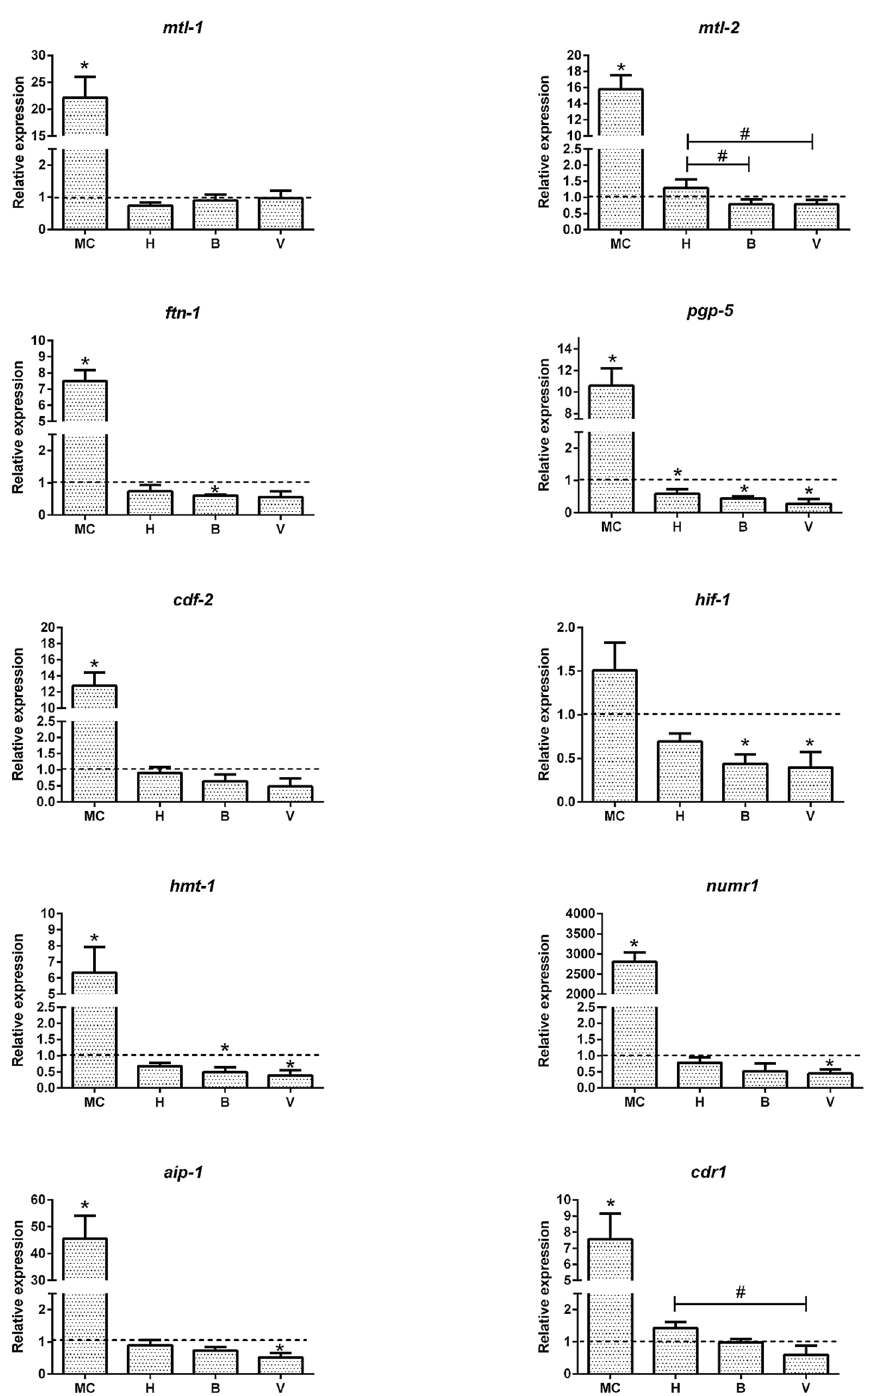
Fig 4. Effect of C . elegans exposure on the metal response genes. Adult C . elegans treated with the metal cocktail (MC) or waters from Lake Hornträsket (H) and Vombäcken stream at Björn å s (B) and the exit to Vindelälven (V) were analyzed for the expression of ten metal response genes; mtl-1 , mtl-2 , ftn-1 , pgp-5 , cdf-2 , hif-1 , numr-1 , aip-1 , cdr-1 , and hmt-1 . One way analysis of variance (ANOVA) followed by Tukey ’ s post-test was used for multiple group comparison where * refers to p < 0.01 as compared to control and # represents significant differences in between the sites H, B and V. The dotted line represents the expression level normalized to that of the control (K-medium prepared with Milli-Q